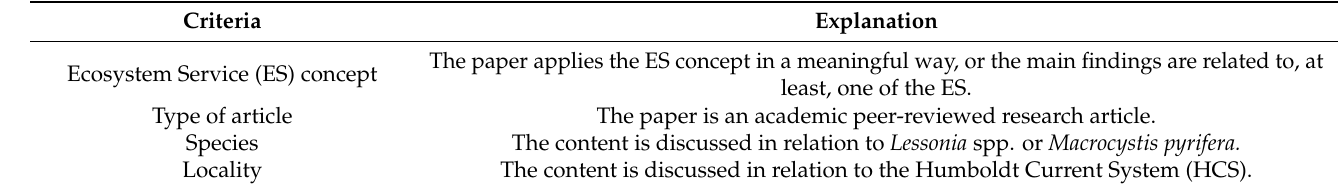
Table 1. Inclusion criteria for papers used in the present review, based on their abstracts (ap- praisal